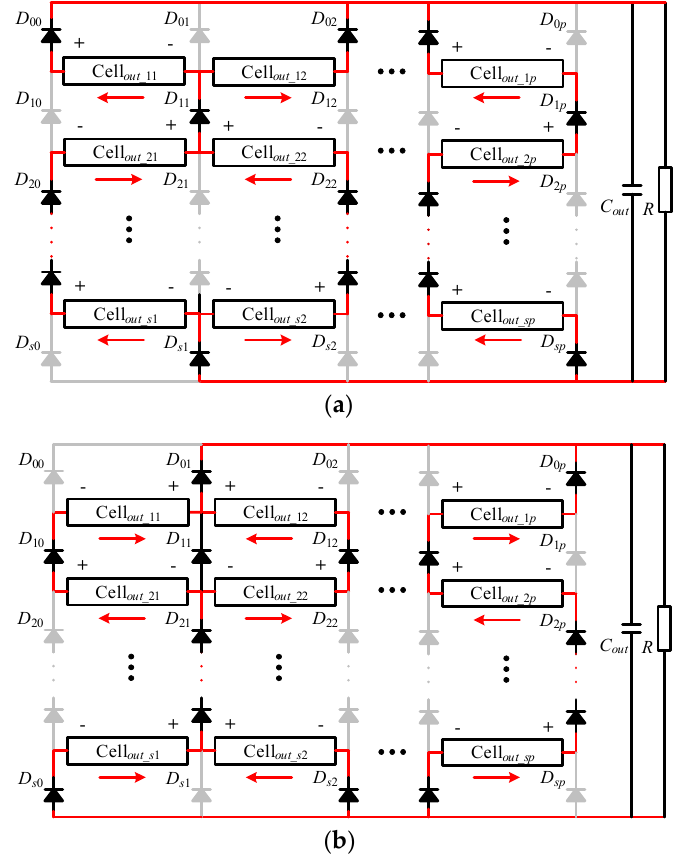
Figure 8. Equivalent secondary circuits of the s × p topology in the column interleaved strategy: ( a ) column interleaved mode 1; ( b ) column interleaved mode 2.